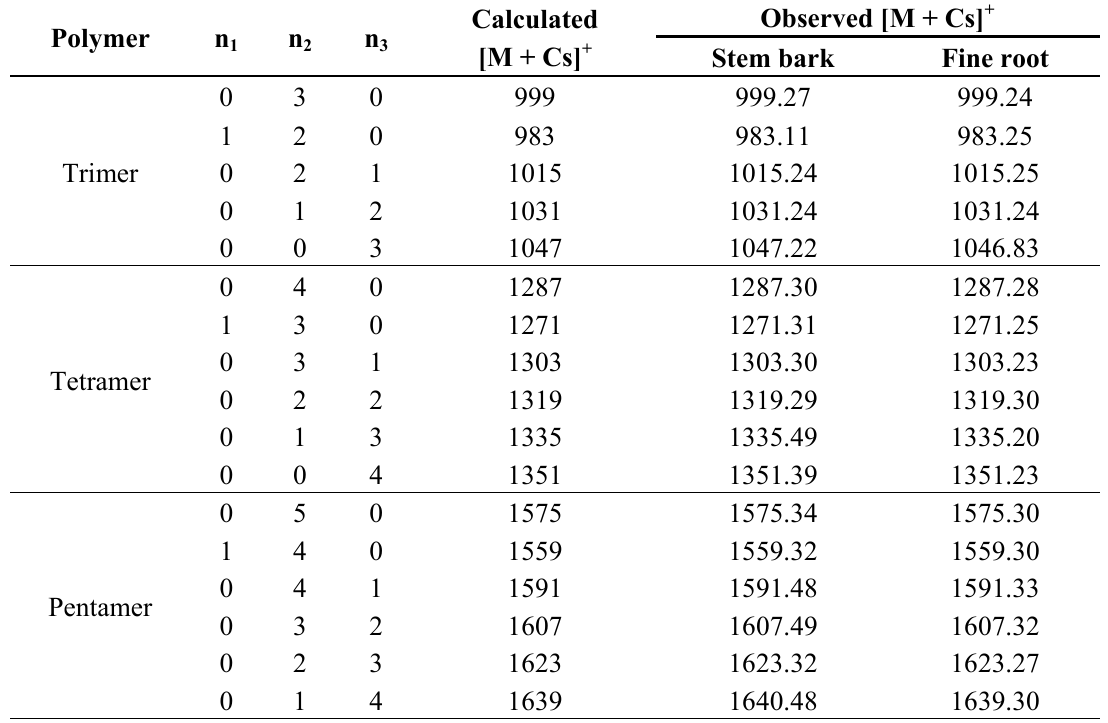
Table 2. Summary of peaks with the highest intensities in MALDI-TOF MS of the condensed tannins from stem bark and fine root of C.